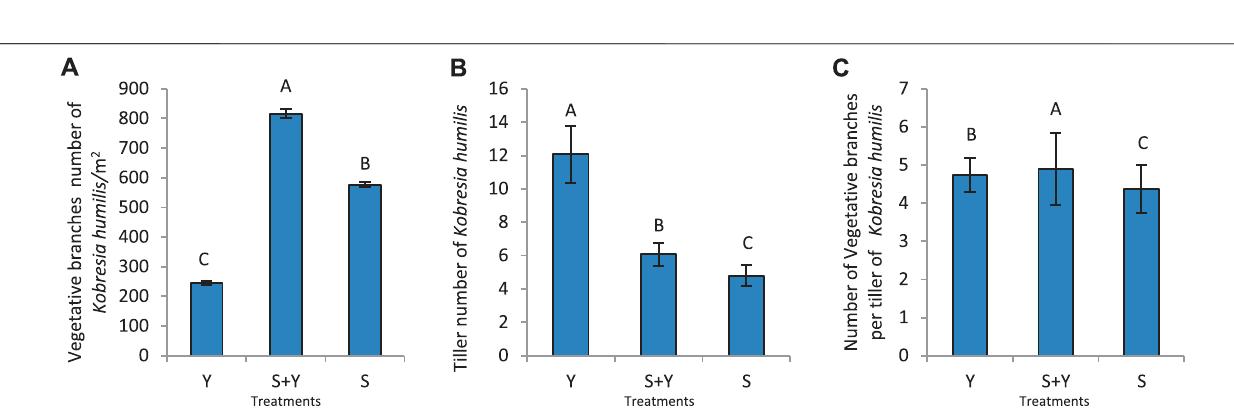
Frontiers in Environmental Science |